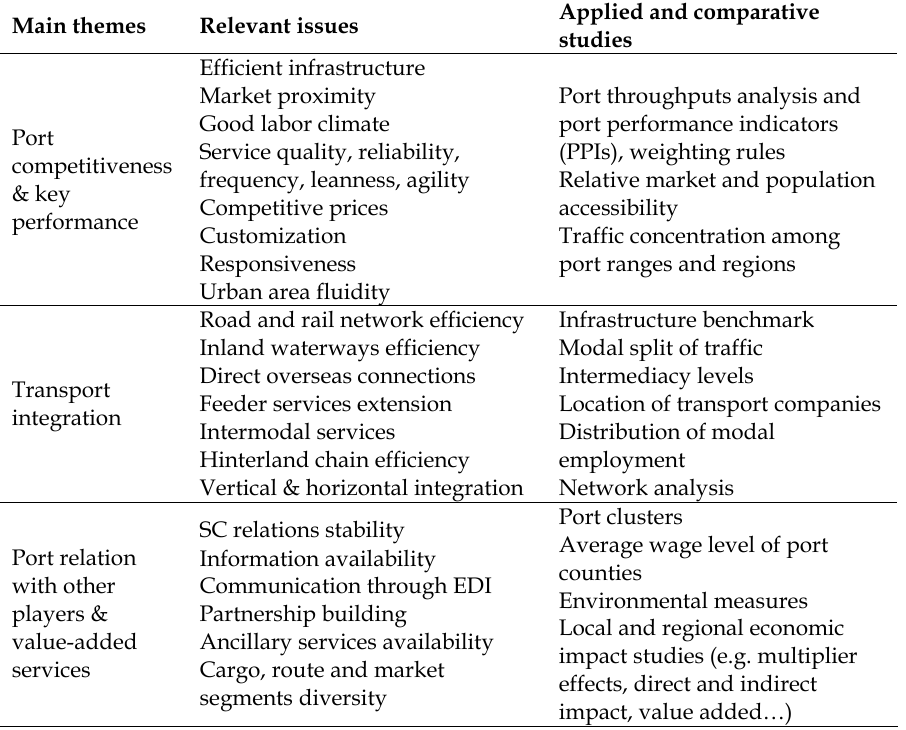
Table 1. Theory and practice among port integration